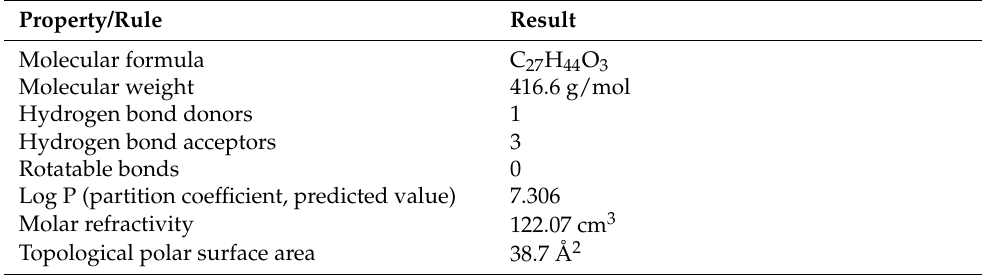
Table 3. Physicochemical and drug-likeness properties of sarsasapogenin.